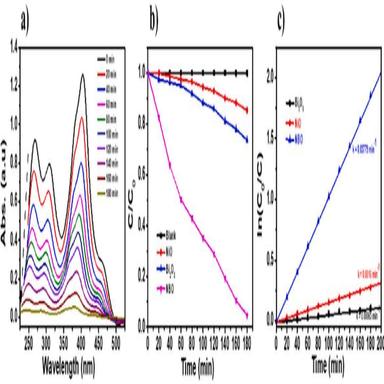
a)Chronological absorbance spectral photodegradation form b) photodegradation of ASP in the presence of pure NiO, Bi2O3 and NBO and c) kinetic plot for ASP photodegradation.